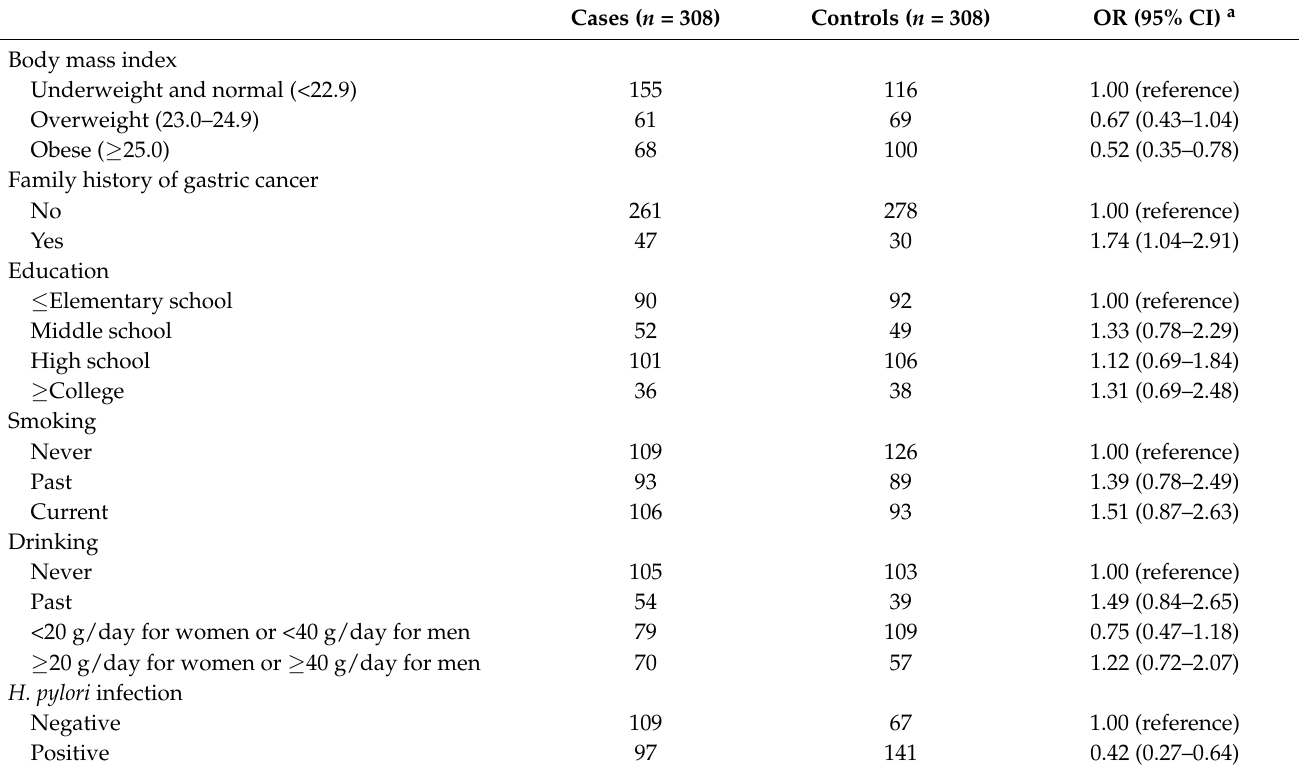
Table 2. Odds ratios (ORs) and 95% confidence intervals (95% CIs) of gastric cancer by general risk factors.